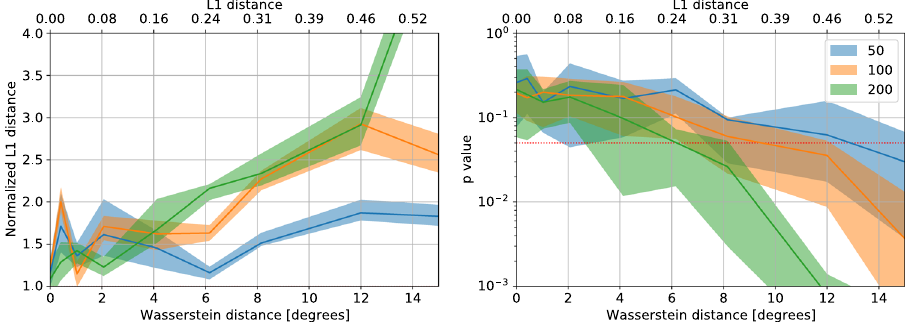
Fig. 6 Normalized L 1 distance statistics and p values obtained comparing pairs of synthetic samples. Samples were drawn from anisotropic von-Mises distributions with standard deviations of 35° in the φ direction and 18° in the ψ direction. One of the distributions was rotated by an increasing angle; the ground truth distance between the distributions was measured using the Wasserstein (W2) and L 1 metrics. Three sample sizes ( N = 50, 100, and 200) are shown. Con fi dence intervals are 20%- and 80%-percentiles calculated on 10 random trials. Larger sample sizes allow to discern smaller distribution changes with higher signi fi cance.